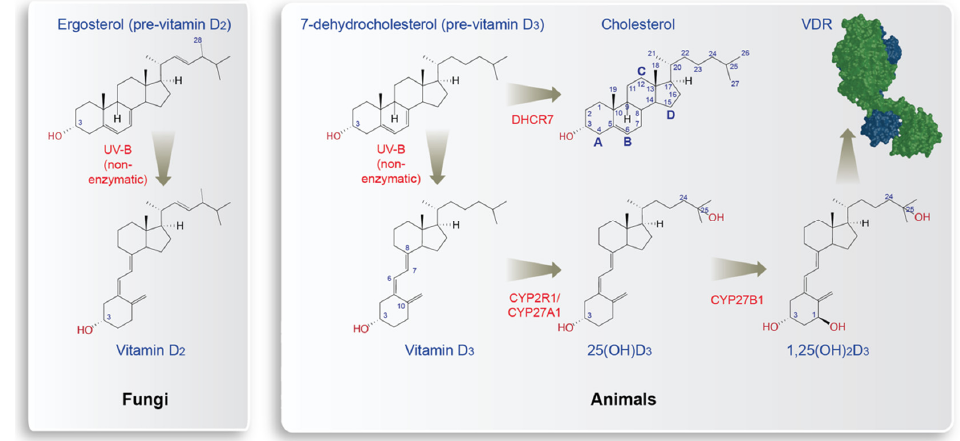
Figure 1. Principles of endogenous vitamin D 2 and vitamin D 3 production. In fungi, vitamin D 2 is produced non-enzymatically when the sterol ergosterol is exposed to UV-B radiation. In cholesterol synthesizing animals (as well as in some plants, such as phytoplankton), 7-dehydrocholesterol reacts to vitamin D 3 using the energy of UV-B. Animals express enzymes that convert vitamin D 3 first to 25(OH)D 3 and then to 1,25(OH) 2 D 3 . In animals (but not in fungi), vitamin D endocrinology developed and 1,25(OH) 2 D 3 acts as a hormone binding with high affinity to the nuclear receptor VDR (green, the co-receptor RXR is shown in blue). In the example of cholesterol, the numbering of rings (A-D) and carbons (1-27) is indicated, while only key carbons are marked in the other molecules.